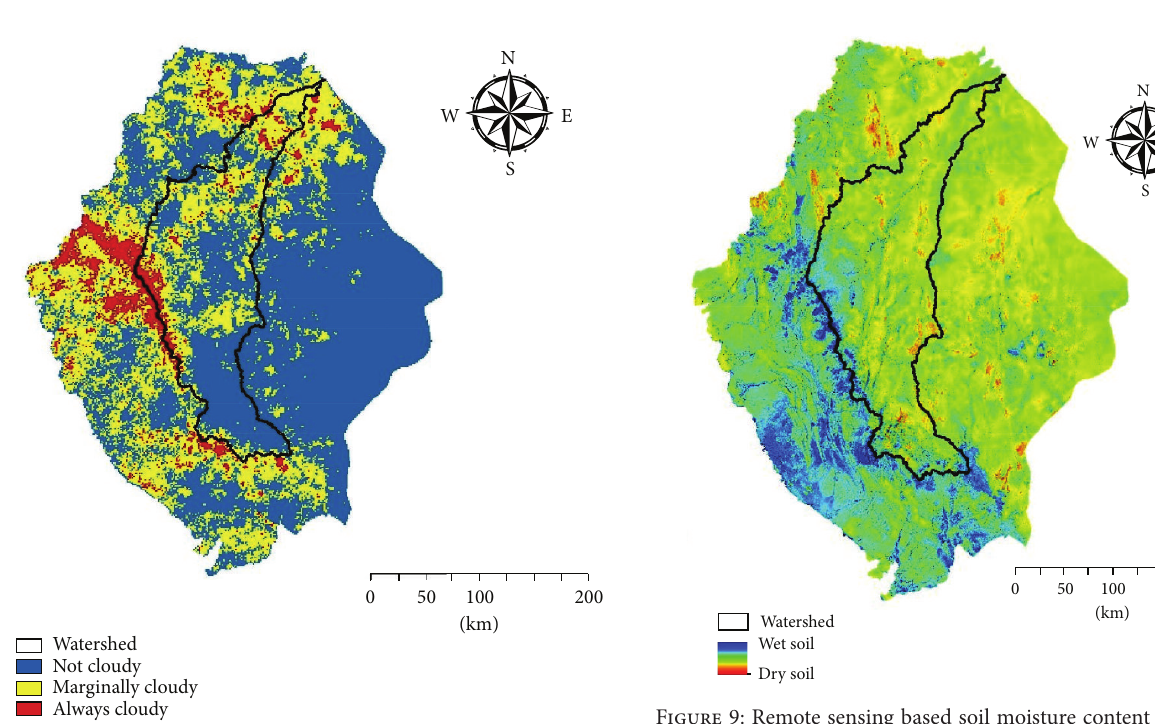
Figure 9: Remote sensing based soil moisture content map of the southern part of KSA.